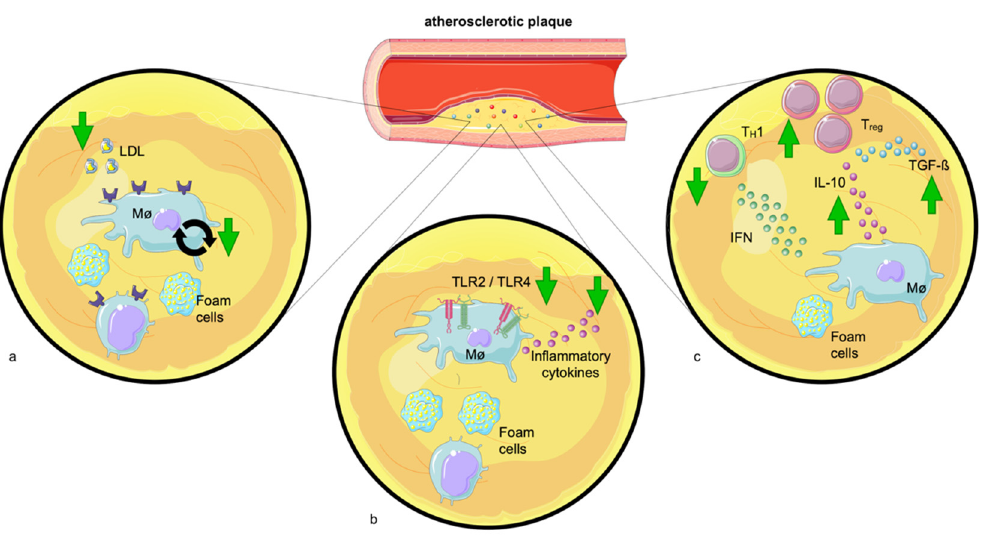
Figure 3. Exercise attenuates the pro-inflammatory environment of atherosclerotic plaques. ( a ) Exercise lowers LDL levels and may hence decrease LDL-induced plaque macrophage proliferation. ( b ) Physical exercise decreases Toll-like receptors (TLRs) − 2 and − 4 levels. The reduction in TLR expression diminishes the release of pro-inflammatory cytokines by plaque macrophages. ( c ) Exercise elevates the number of immunomodulatory T REG cells which promote plaque stability producing interleukin-10 (IL-10) and transforming growth factor (TGF- β ). Additionally, physical exercise reduces the quantity of T H 1 cells which activate macrophages by interferon-gamma (IFN- γ ) production. Further, atherosclerotic lesions include helper and cytotoxic T cells, which secrete